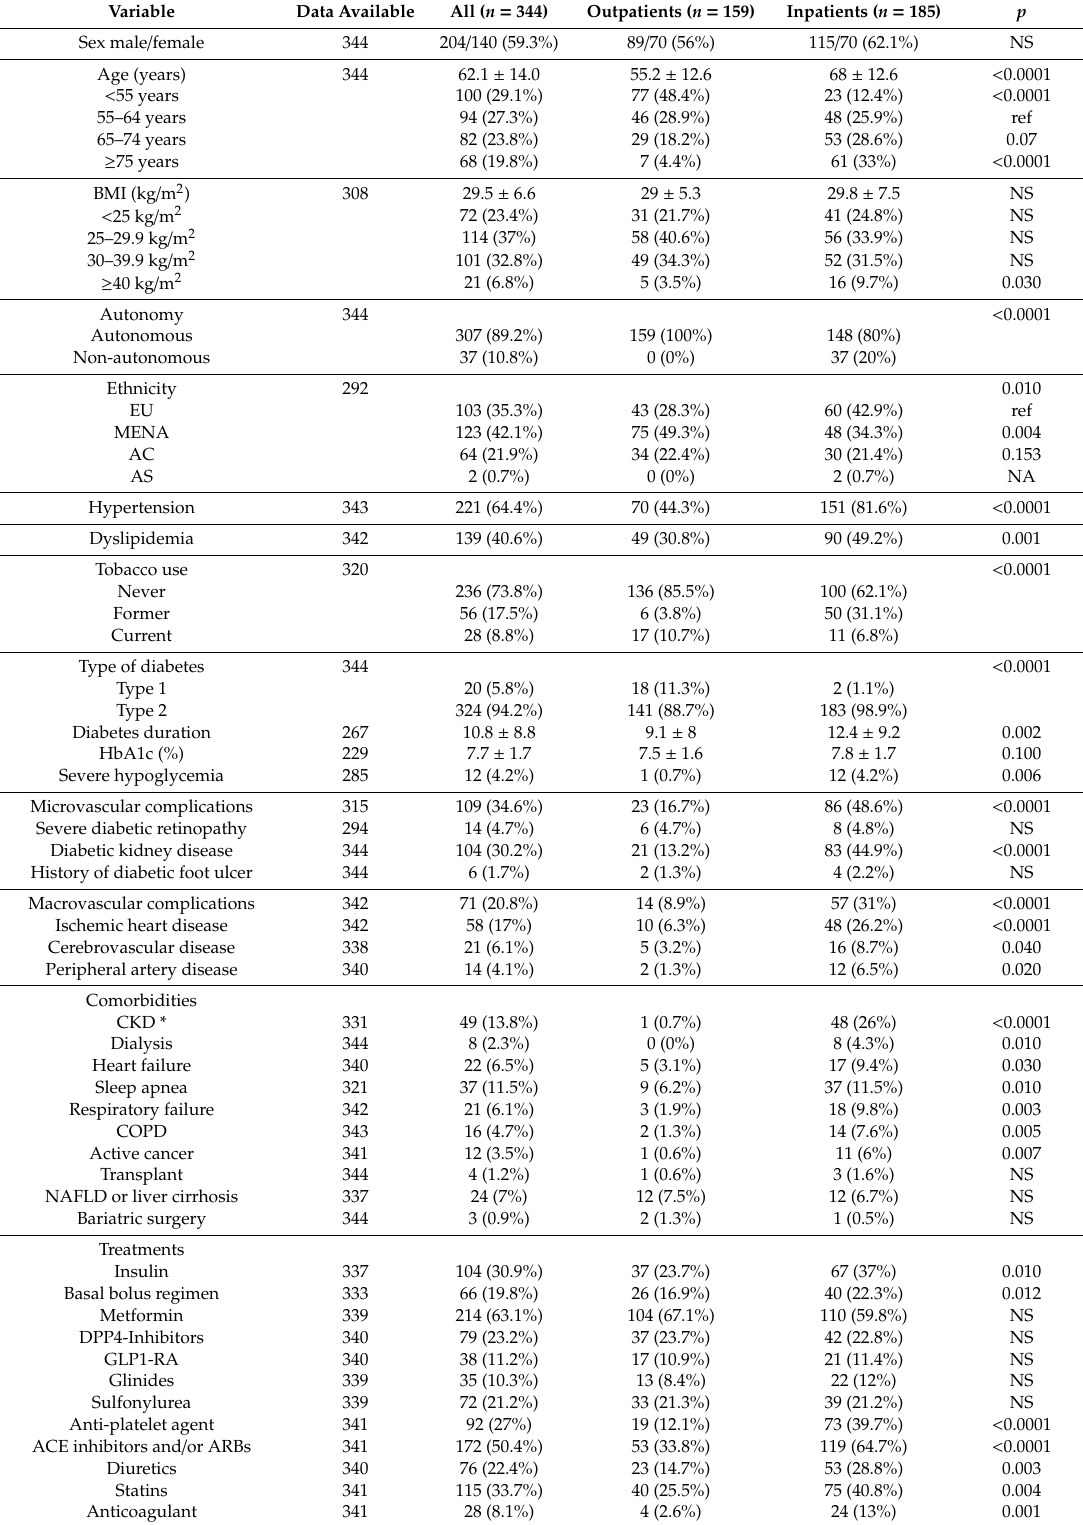
Table 1. Clinical characteristics prior to first